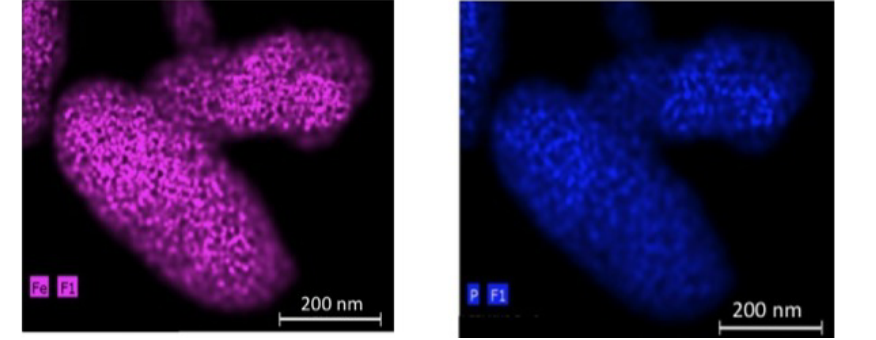
-LiMnPO and LiMn Fe PO 4 4 2/3 1/3 4